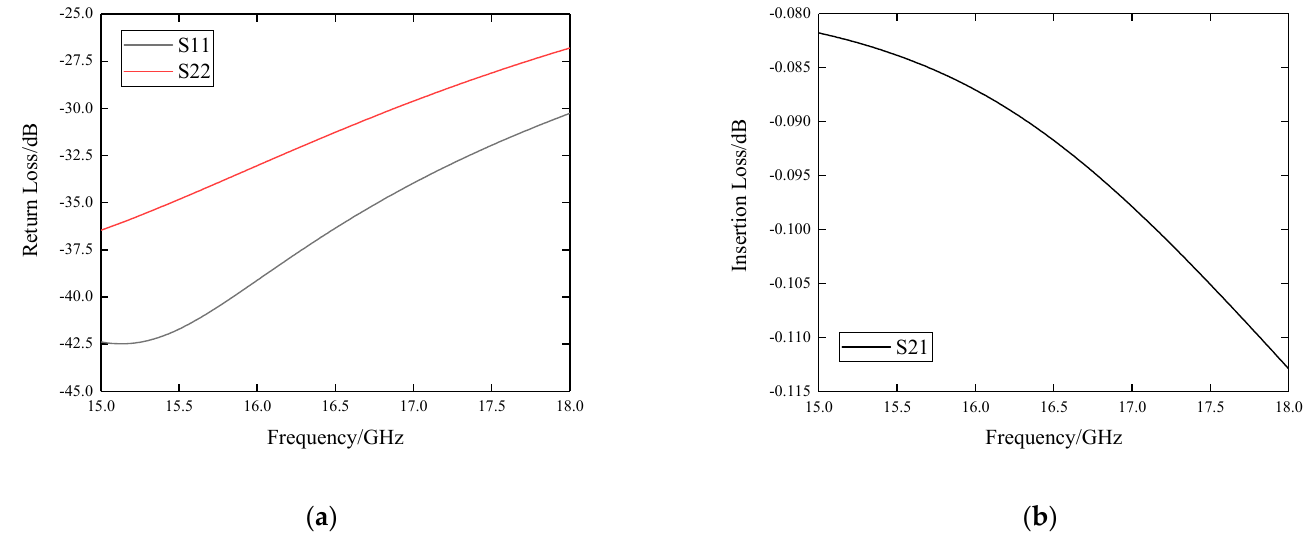
Figure 5. Simulation results of the SMP-to-microstrip vertical transition. ( a ) Return loss S11 and S22 ; ( b ) Insertion loss S21 .